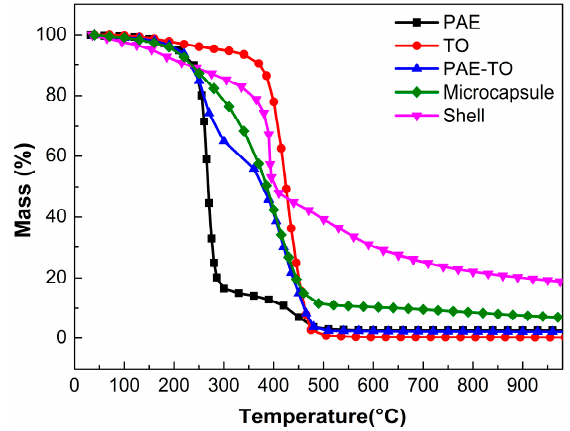
Figure 11. TGA curves of PAE, TO, the mixture of PAE and TO, microencapsulated PAE/TO and MF shell.